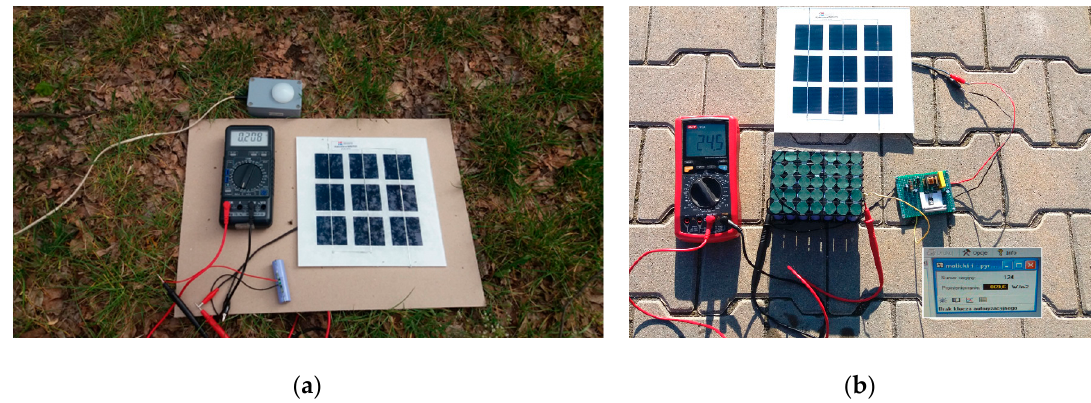
Figure 1. Photos of an integrated system composed of one ( a ) or 42 ( b ) lithium-ion batteries and new photovoltaic (PV) module.